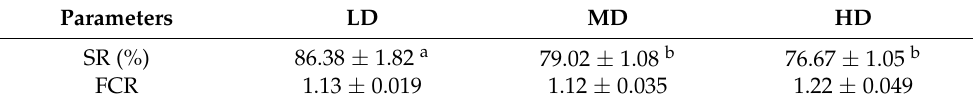
Table 1. Cont. Parameters